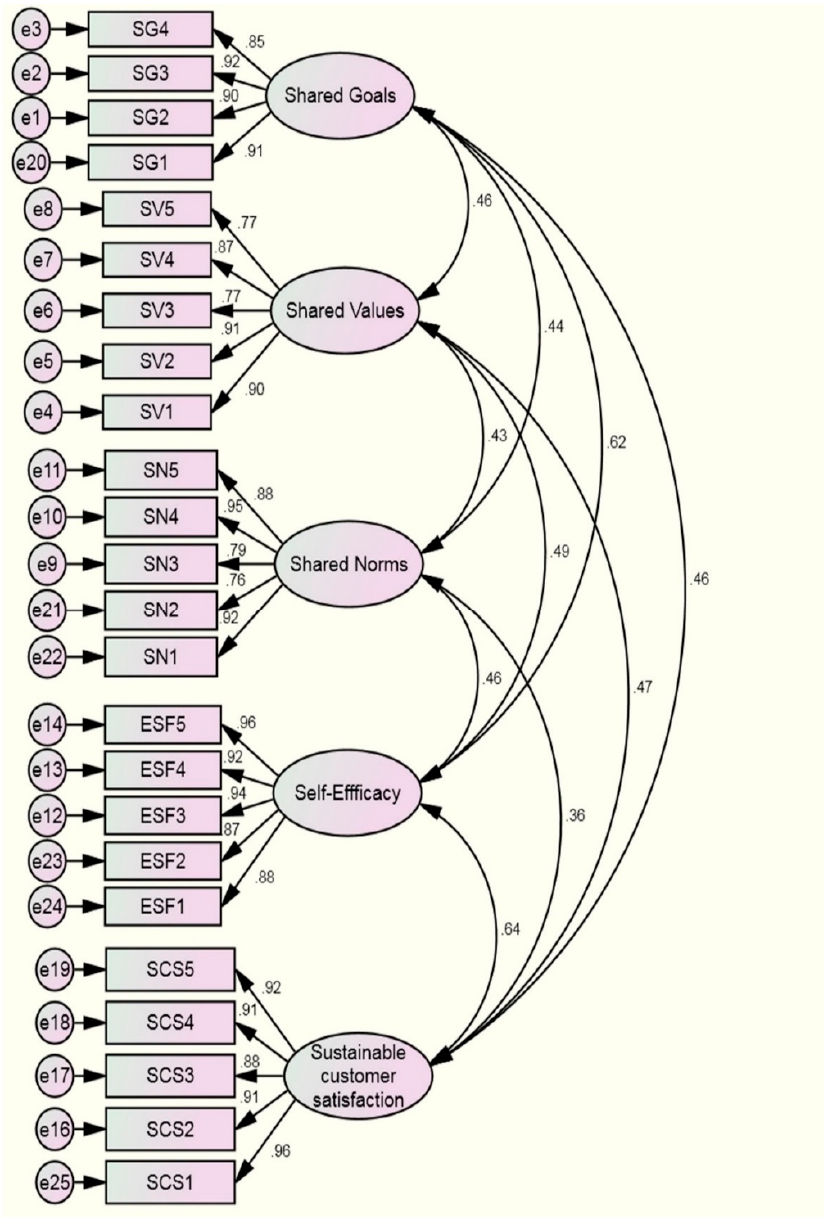
Figure 2. First-order factor analysis.